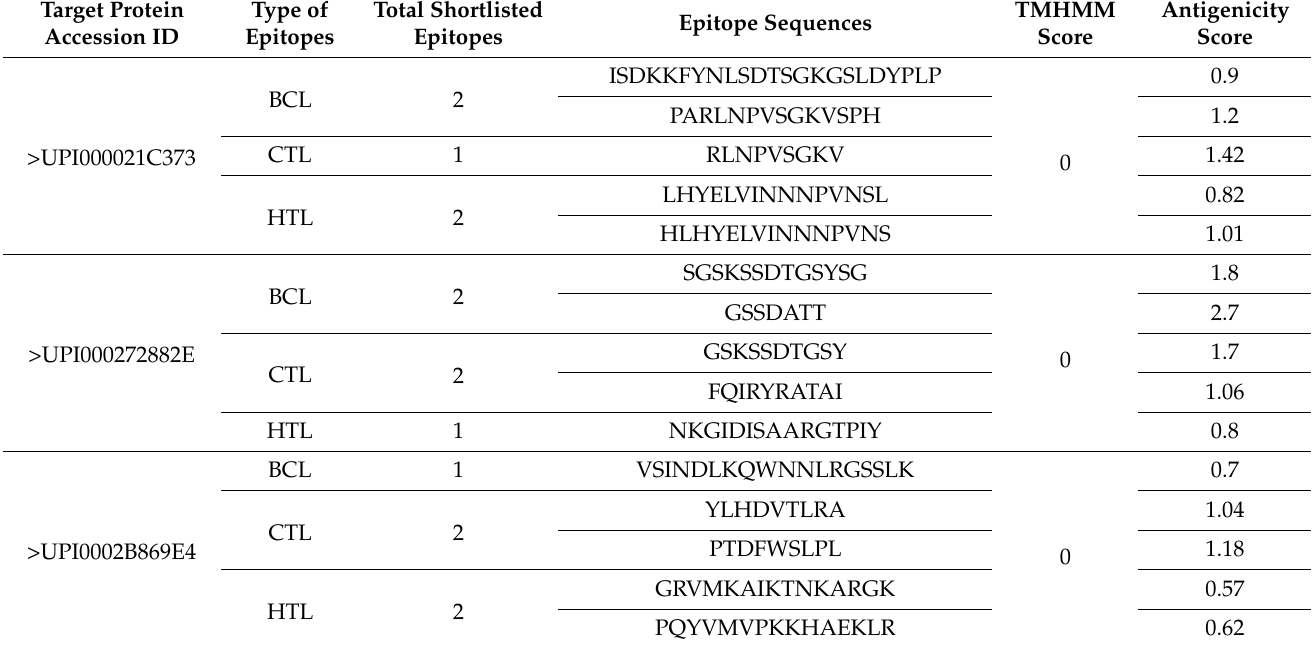
Table 2. Predicted B-cell lymphocyte (BCL), cytotoxic T-cell lymphocyte (CTL), and helper T-cell lymphocyte (HTL) epitopes with their antigenicity and